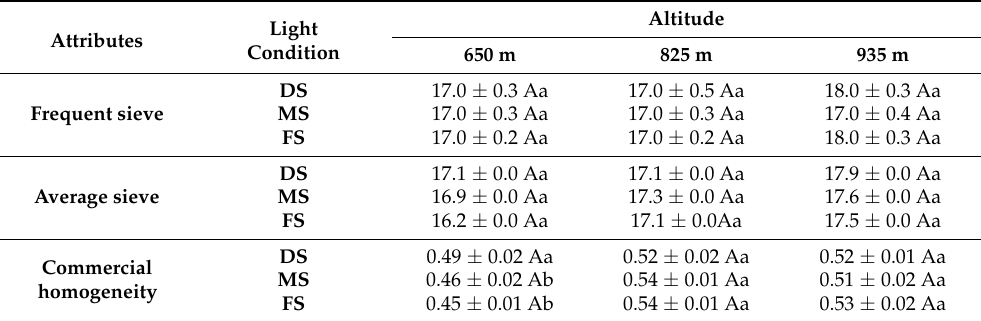
Mean values ± SE (n = 5) followed by the same letter, comparing light conditions within each altitude (A, B) or altitude treatments within each light condition (a, b), are not significantly different according to the Tukey’s HSD for mean comparison ( p < 0.05), always separately for each